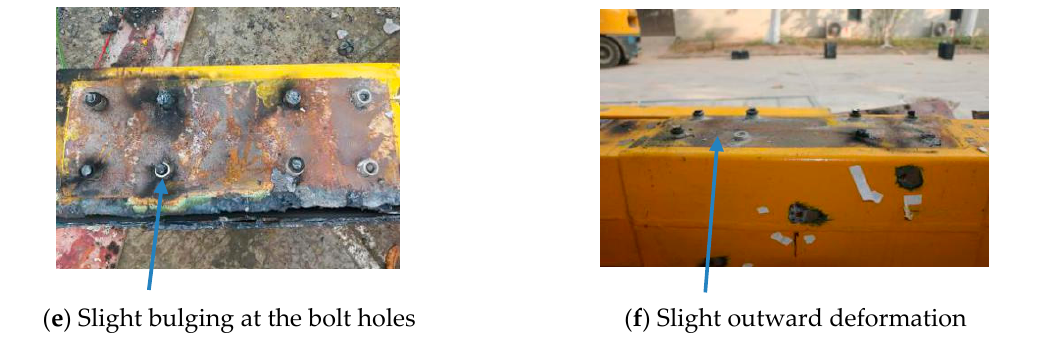
Figure 8. Failure mode II (specimens with a weak end-plate). ( a ) SJ-3; ( b ) SJ-5; ( c ) SJ-6; ( d ) Welding fracture in specimen SJ-3; ( e ) Column wall in specimen SJ-3; ( f ) Column wall in specimen SJ-5.